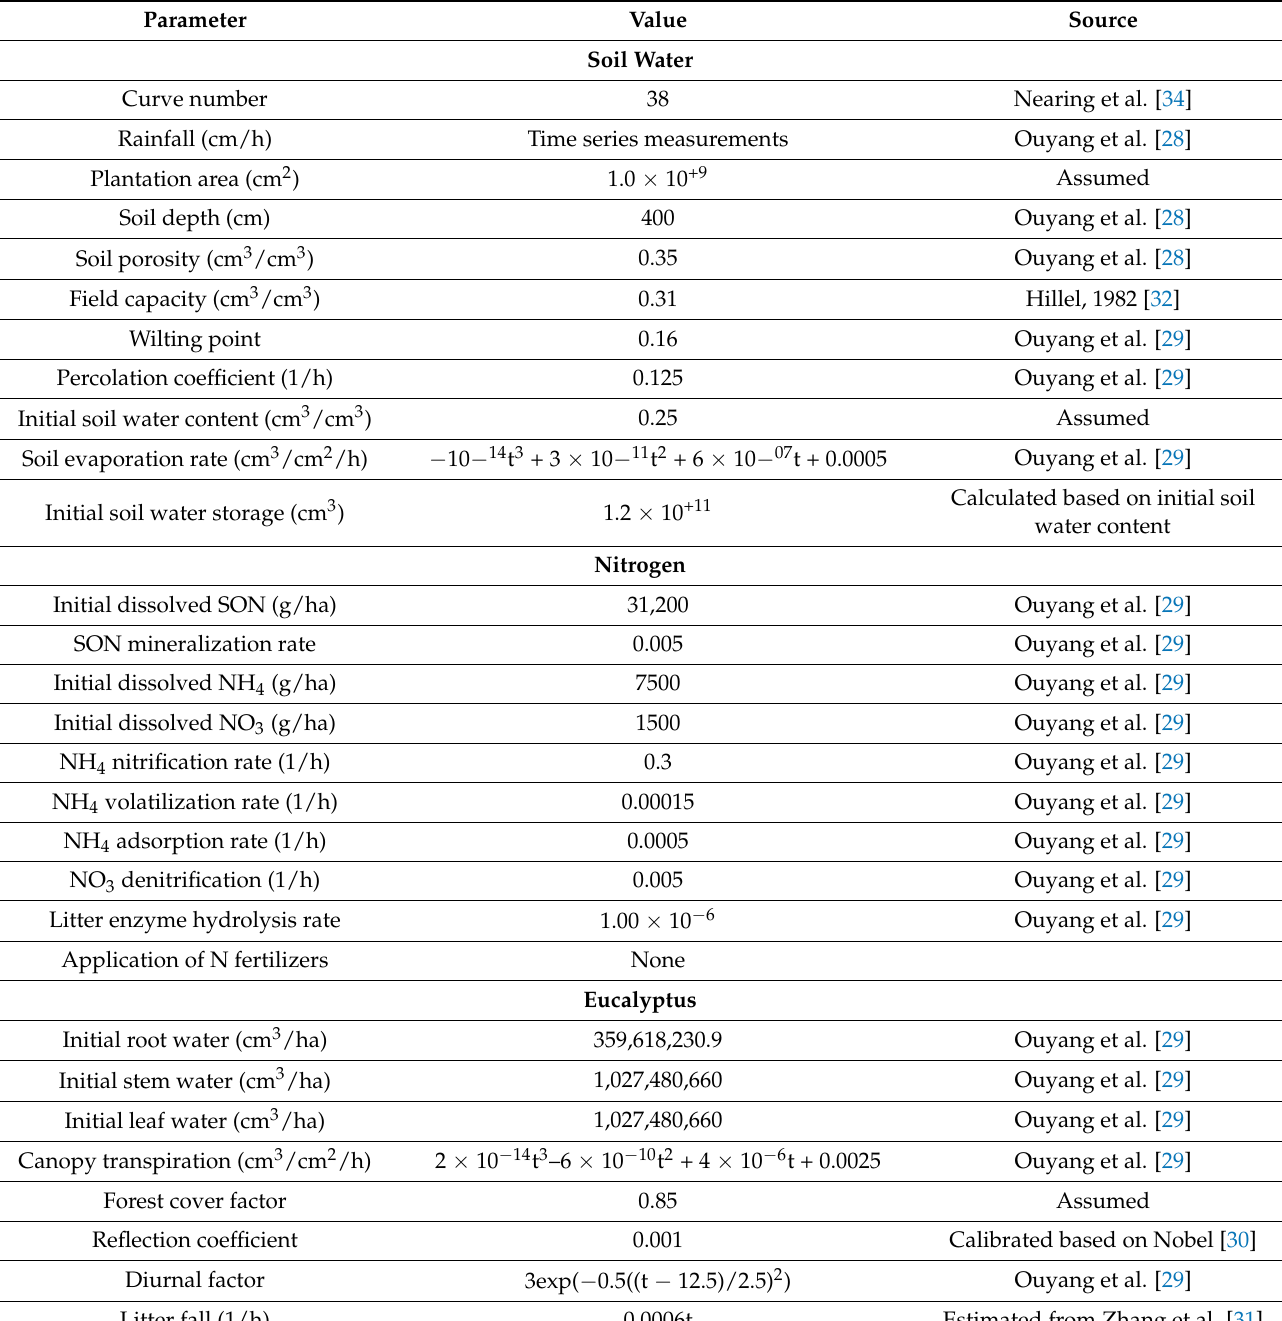
Table 2. Input parameter values used for model validation and